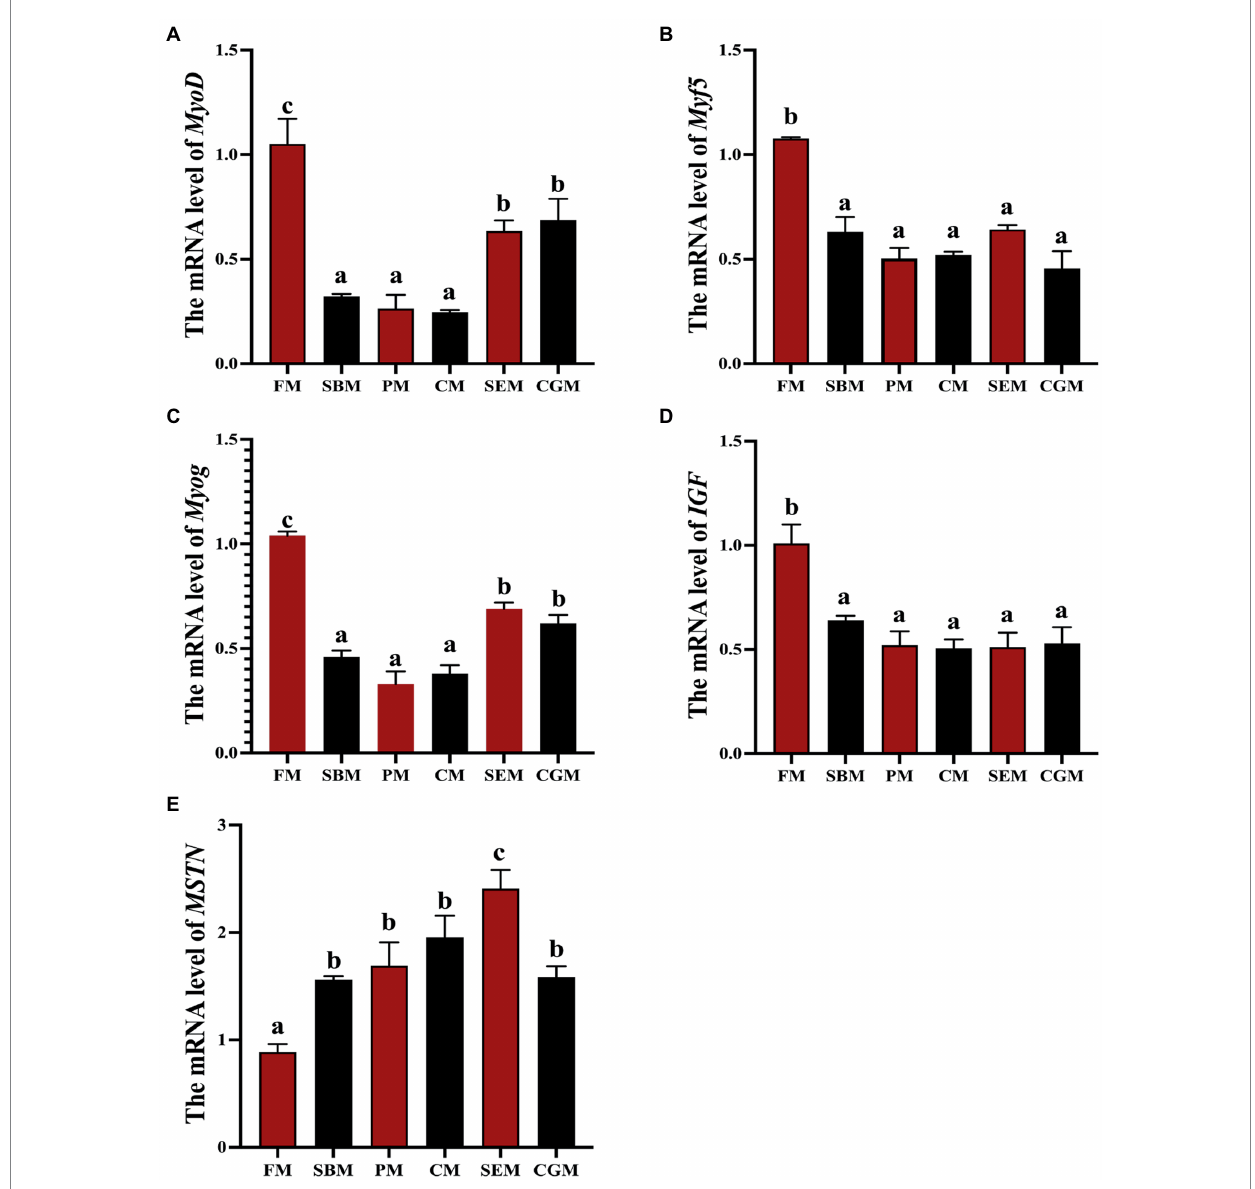
FIGURE 1 The relative expression levels of myogenic genes ( MyoD , Myf5 , Myog , IGF , MSTN ) of muscle in yellow catfish (A – E) . Data from the FM group was set to 100% and used to normalize the remaining values. Within the figure, values without a common superscript letter (a–c) are different (c indicates a higher value). The dissimilar letters indicate significant differences ( p < 0.05), values are means ± SEM of 3